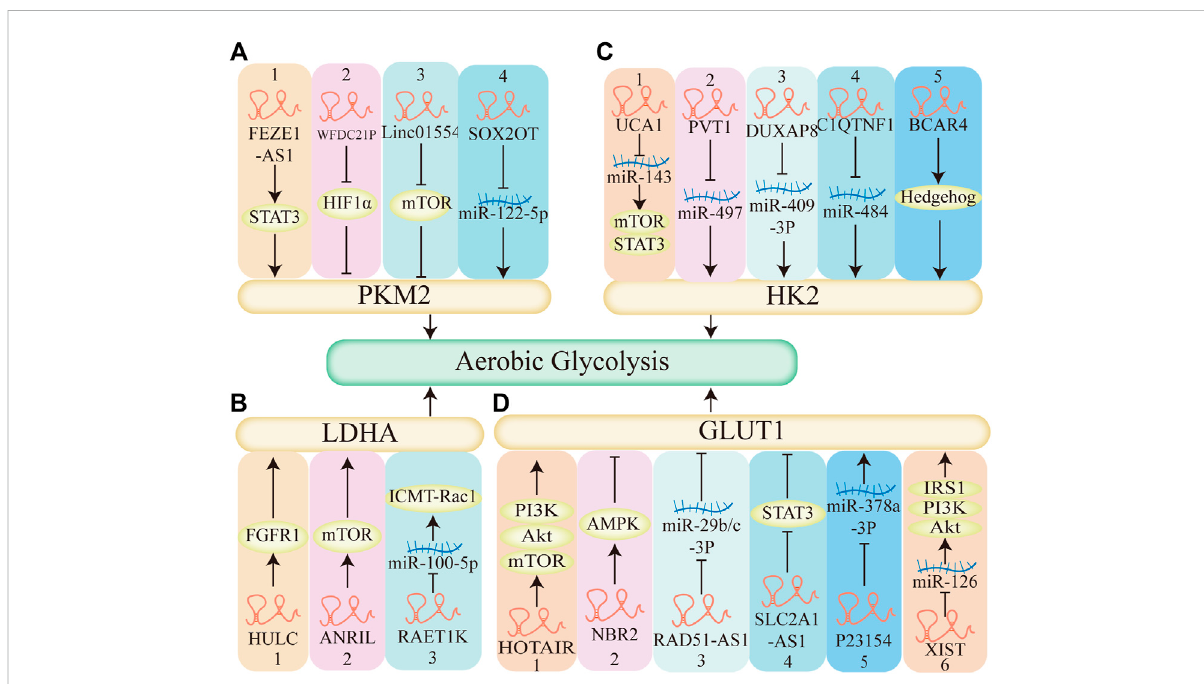
FIGURE 7 The mechanism of LncRNAs regulate aerobic glycolysis. (A) LncRNAs regulate aerobic glycolysis through pyruvate kinase M2 (PKM2). 1 – 3. LncRNA-FEZF1-AS1, LncRNA-WFDC21P, Linc01554 regulates STAT3, HIF1 α , mTOR pathway respectively, affects the expression of PKM2, regulates aerobic glycolysis. 4. LncRNA-SOX2OT decreases the expression of miR-122-5p, upregulates PKM2, promotes aerobic glycolysis. (B) LncRNAs regulate aerobic glycolysis through Lactate dehydrogenase A (LDHA). 1 – 2. LncRNA HULC, LncRNA ANRIL elevates FGFR1 and mTOR, respectively, regulates LDHA, enhances aerobic glycolysis. 3.LncRNA RAET1K decreases the expression of miR-100-5P, upregulates the expression of LDHA, promotes aerobic glycolysis. (C) LncRNAs regulate aerobic glycolysis through hexokinase 2 (HK2). 1. LncRNA UCA1 acts as a molecular sponge of miR-143, activates the mTOR pathway, promotes aerobic glycolysis. 5. LncRNA BCAR4 coordinates the Hedgehog signaling pathway, enhances the HK2 and aerobic glycolysis. 2 – 4. LncRNA PVT1, LncRNA DUXAP8, LncRNA C1QTNF1 acts as a molecular sponge of miR-497, miR- 409-3P, miR-484 respectively, promotes the expression of HK2, enhances aerobic glycolysis. (D) LncRNAs regulate aerobic glycolysis through glucose transporter1(GLUT1).1,2,4: LncRNA HOTAIR, LncRNA NBR2, LncRNASLC2A1-AS1 regulates mTOR, AMPK, STAT3 pathway respectively and affects the expression of GLUT1, affects aerobic glycolysis. 3,5: LncRNA RAD51-AS1, LncRNA P23154, acts as a molecular sponge of miR-29b/c-3P, miR-378a-3P respectively, regulates the expression of GLUT1, affects aerobic glycolysis. 6. LncRNA XIAT acts as a molecular sponge of miR-126, activates the PI3K pathway and the expression of GLUT1, promotes aerobic